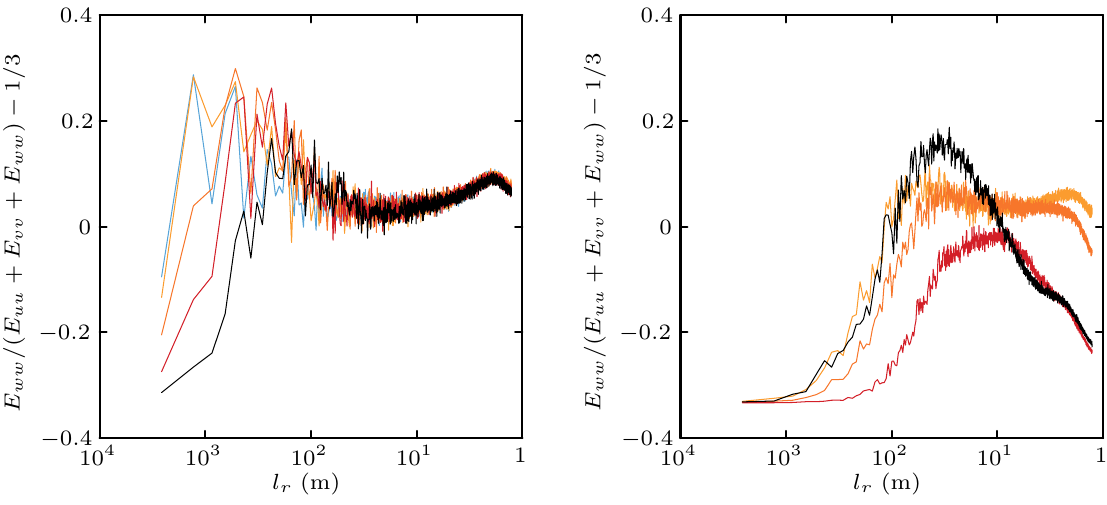
Figure 12. Velocity-anisotropy parameter at different heights. Lines are as in Figure